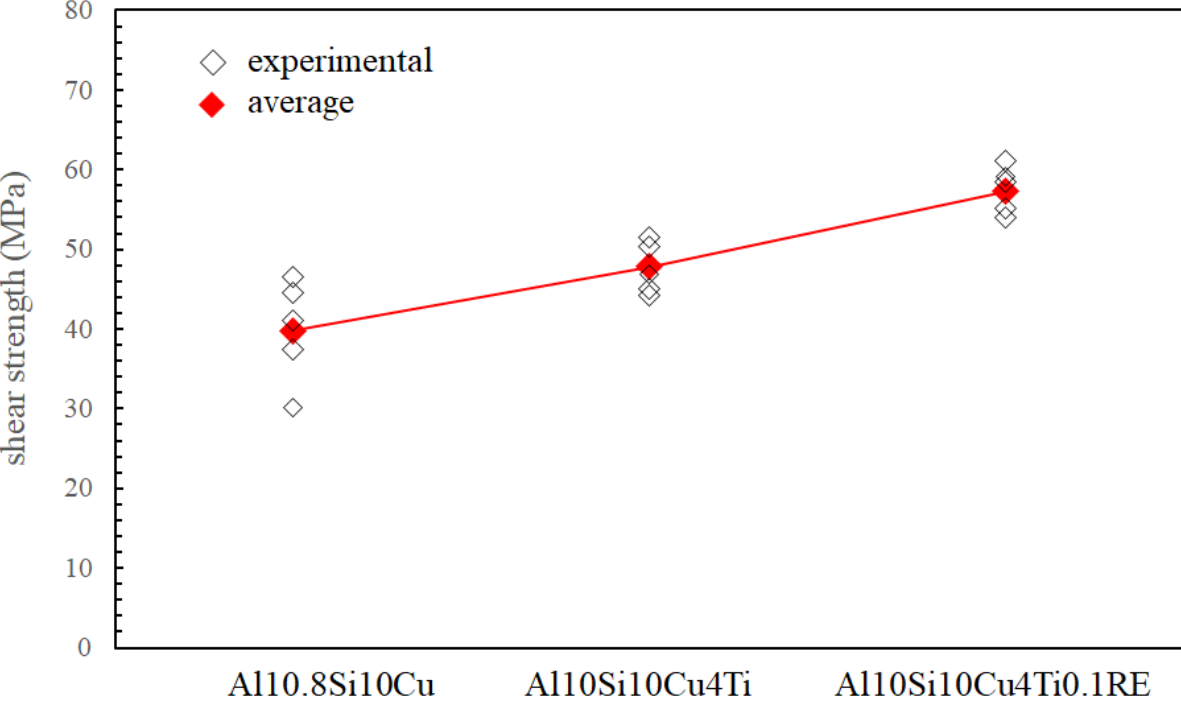
Figure 6. The shear strengths of AA6061/AA6061 joints bonded with Al10.8Si10Cu, Al10Si10Cu4Ti and Al10Si10Cu0.1RE filler alloys.